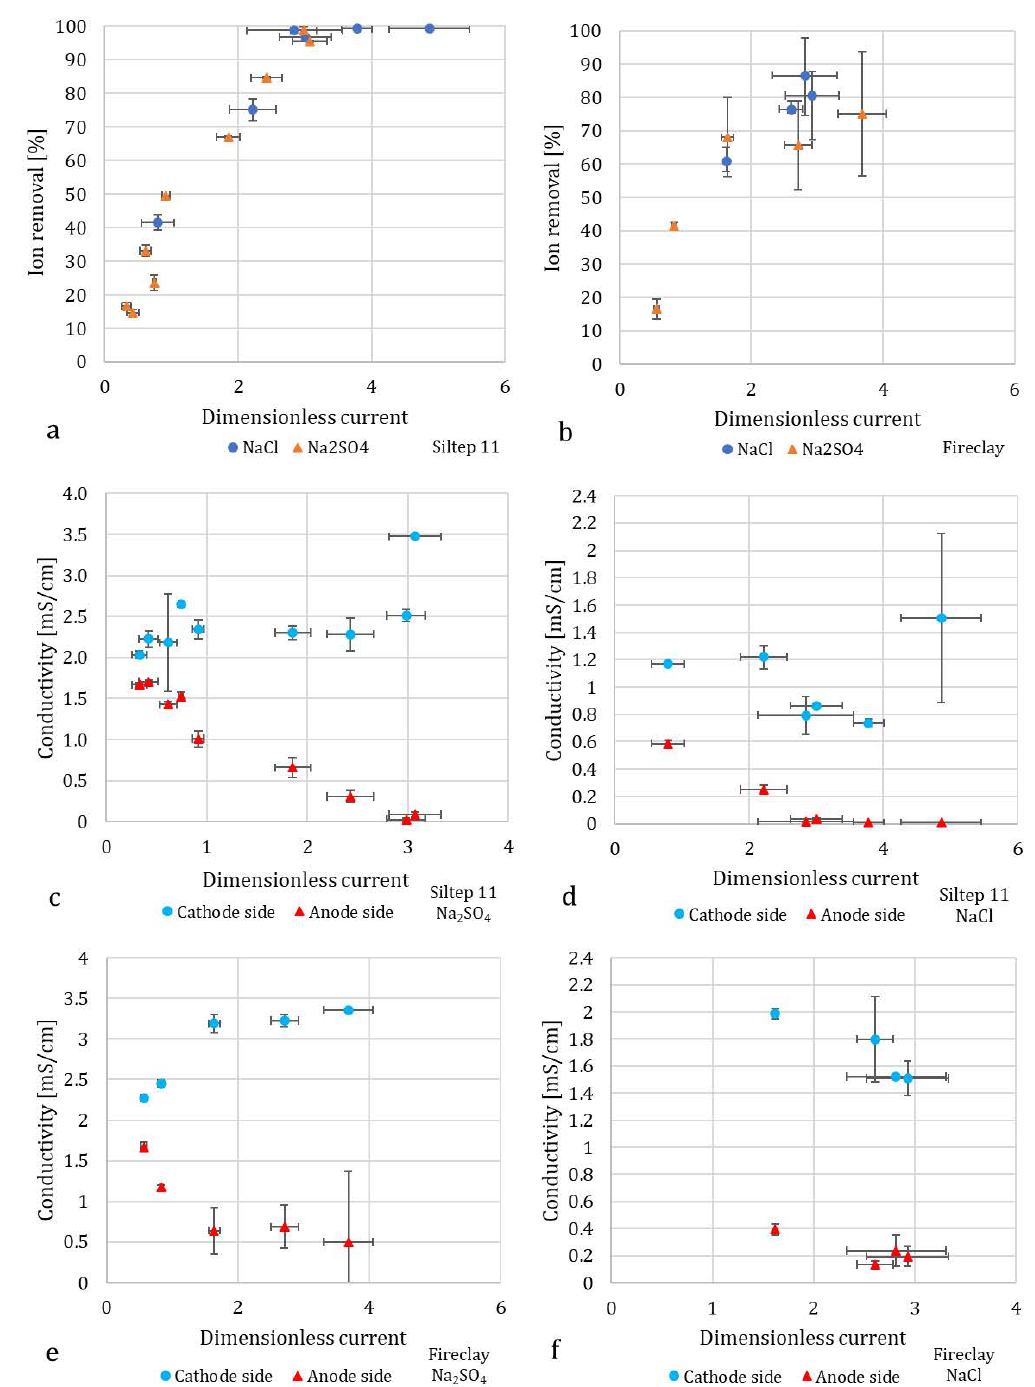
Figure 6. Experimental data for the galvanostatically operated unit with Siltep 11 and foamed fireclay as the porous medium, AEMs, feed concentration 10 mM. ( a , b ) show average desalination as the function of dimensionless current, ( c – f ) show the conductivity of cathode and anode side during these experiments for all the combinations of porous materials and electrolytes. The rather big deviations suggest unstable performance in some cases, which could have been caused by unstable flow rates (visible in ( a , b ) as error bars for the dimensionless current) and pH changes as